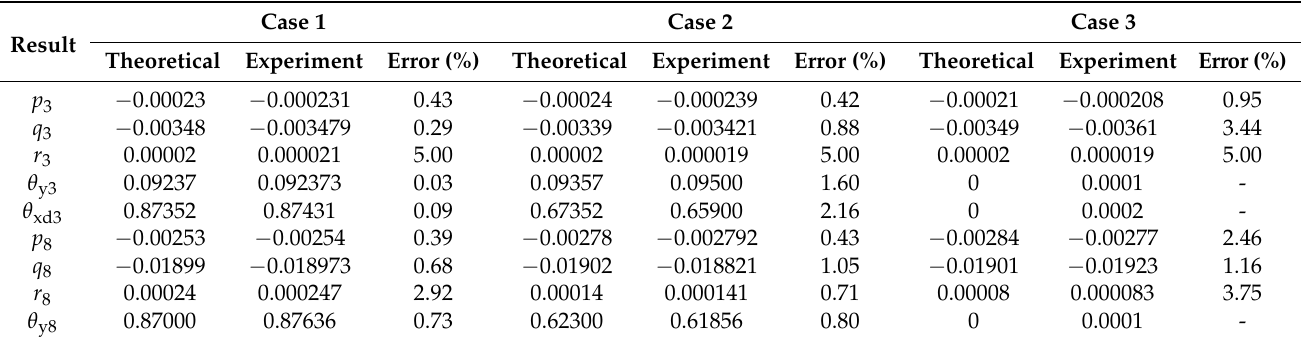
Table 8. Theoretical and experimental results of the displacement and rotation angle of points ( P 1 , P 2 , P 3